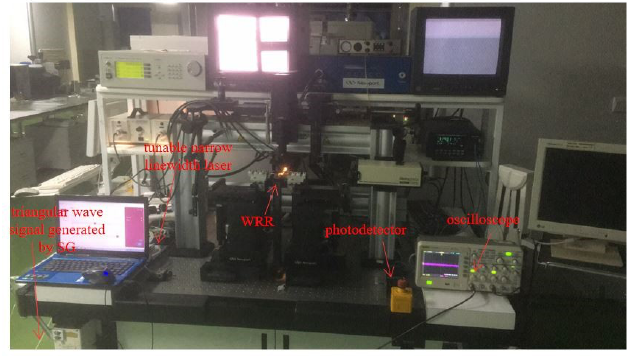
Figure 6 . The measuring instrument of the WRR.